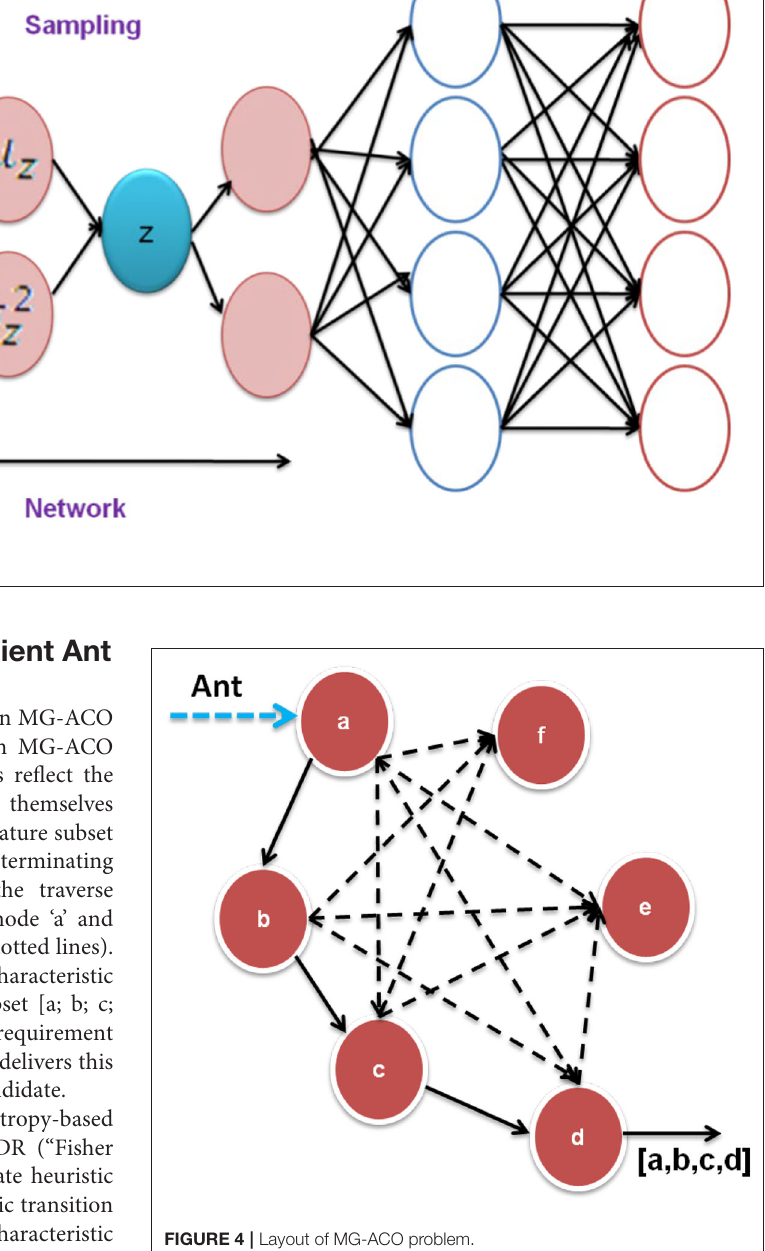
FIGURE 4 | Layout of MG-ACO